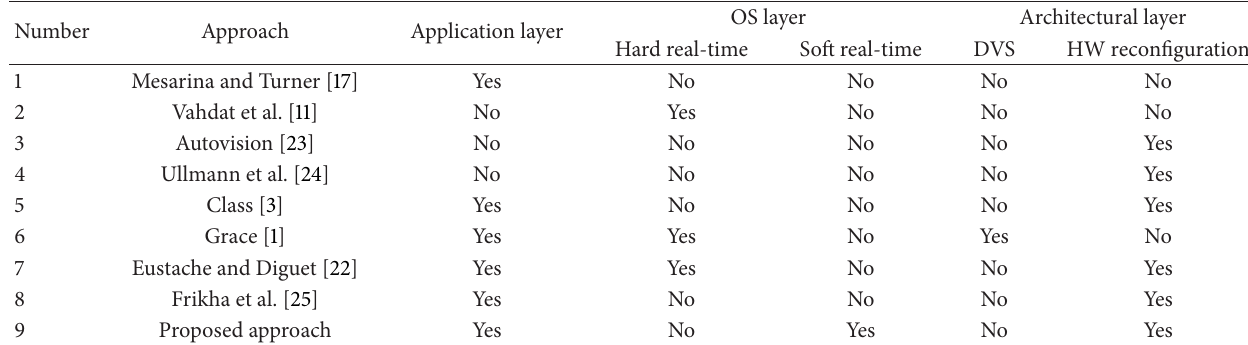
Table 1: Contributions of some